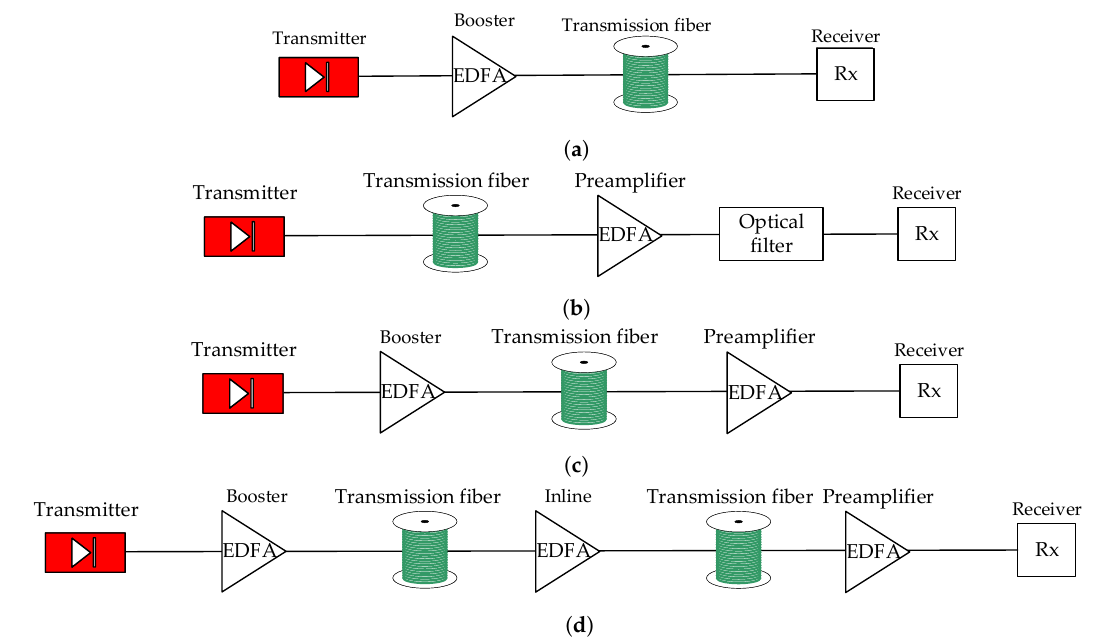
Figure 5. ( a ) Booster-only configuration, for shorter distances (100–150km), ( b ) preamplifier-only configuration, when it is necessary to avoid high-power boosters, ( c ) booster and preamplifier configuration for distances of approximately 200km, ( d ) booster, inline and preamplifier configuration for longer distances (cascaded